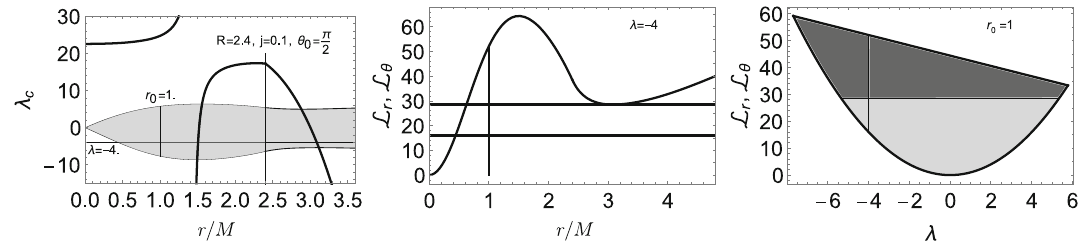
Fig. 9 Effective potentials for objects with compactness R / M = 3 . 2 for several values of j and θ . The solid lines are effective potentials for non-rotating configurations. The dotted and dashed lines denote effective potentials for co-rotating and counter-rotating null geodesics